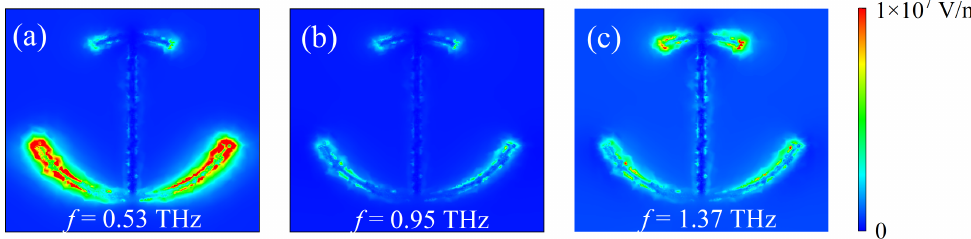
Figure 3. ( a – c ) Electric field distribution of AIGS covered with lactose at different frequencies under vertically incident TM